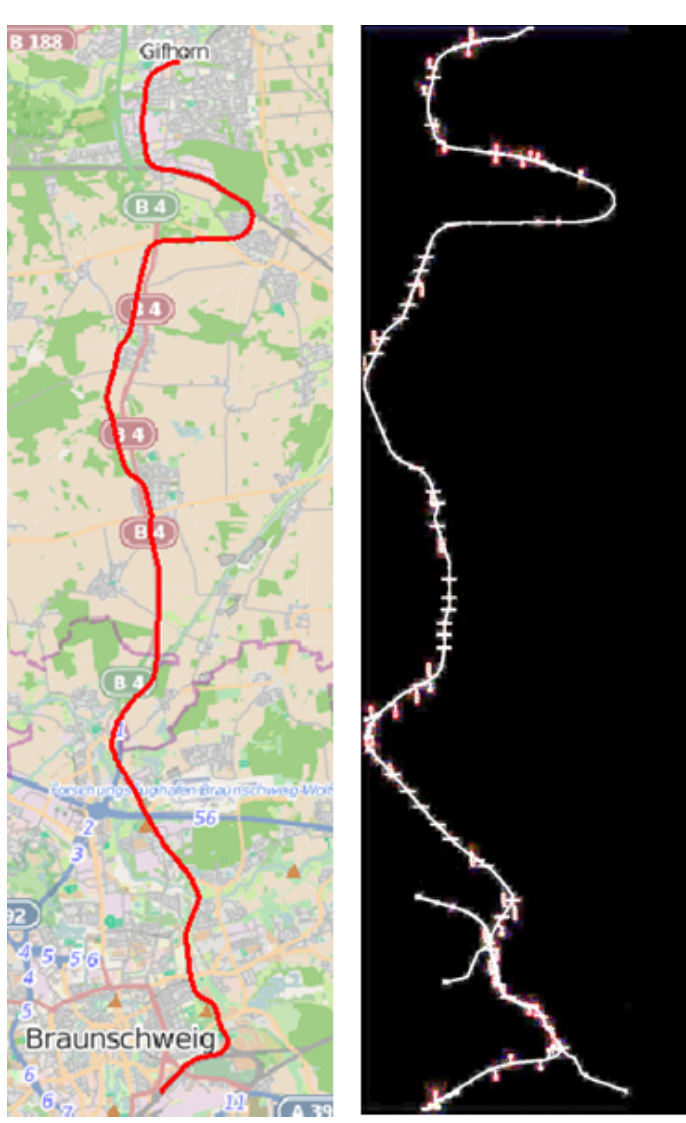
Figure 2: Virtual railway reference track as overlay on OSM (left), with signals and crossings